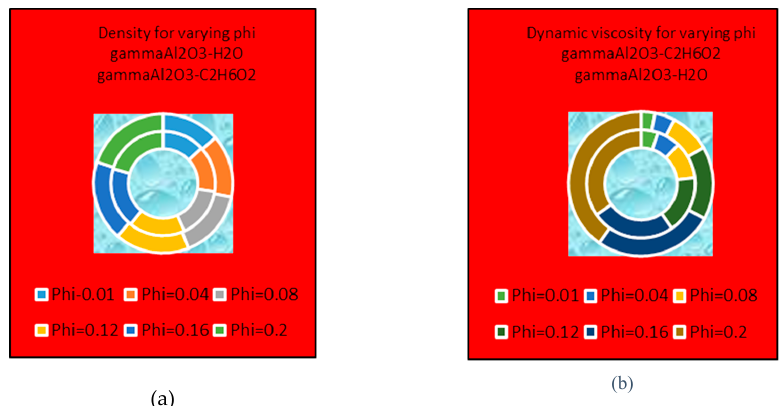
Figure 13. E ff ects of φ on ( a ) dynamic viscosity ( b ) thermal Figure 13. Effects of 𝜙 on ( a ) dynamic viscosity ( b ) thermal conductivity